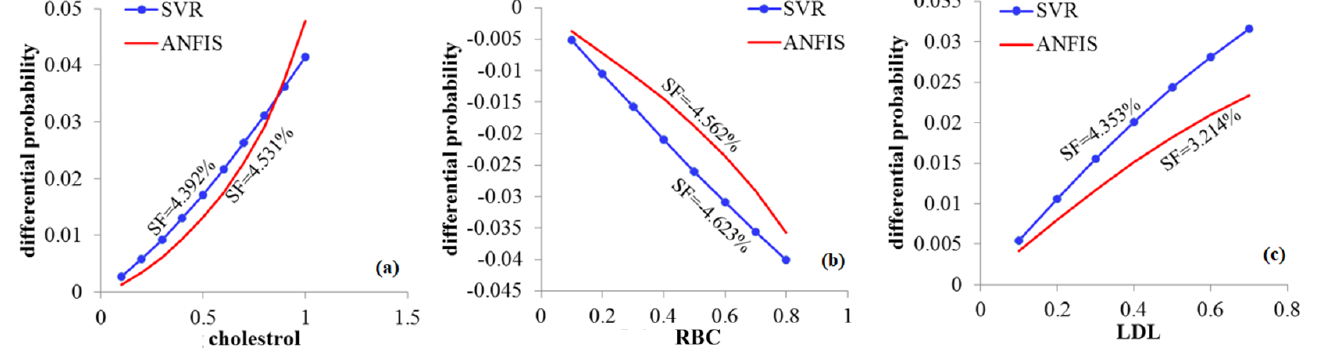
Figure 2. Plots of DFs for cholesterol ( a ), RBC ( b ) and LDL ( c ); see abbreviations in